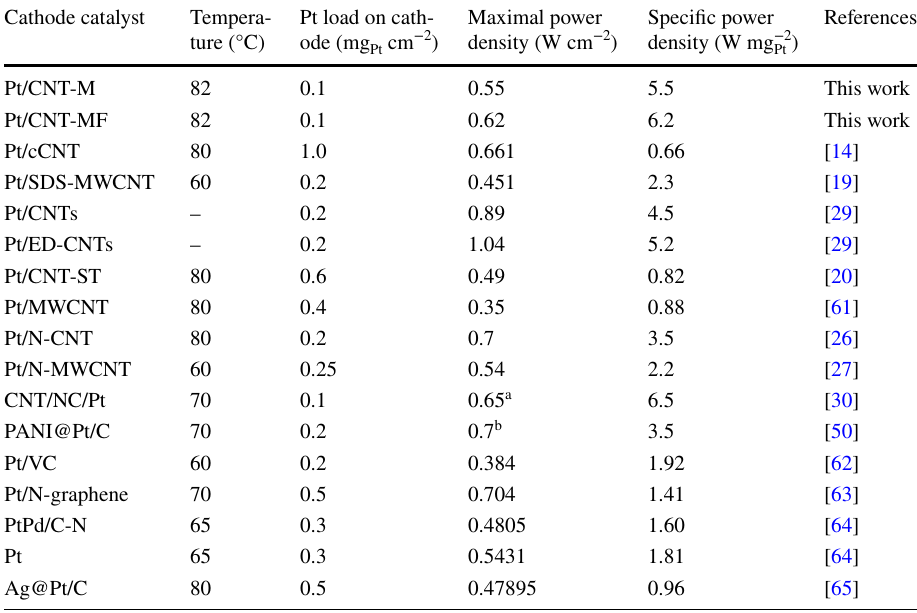
Table 5 Comparison of maximal power densities per geometrical area and mass of Pt obtained in this work and reported in the